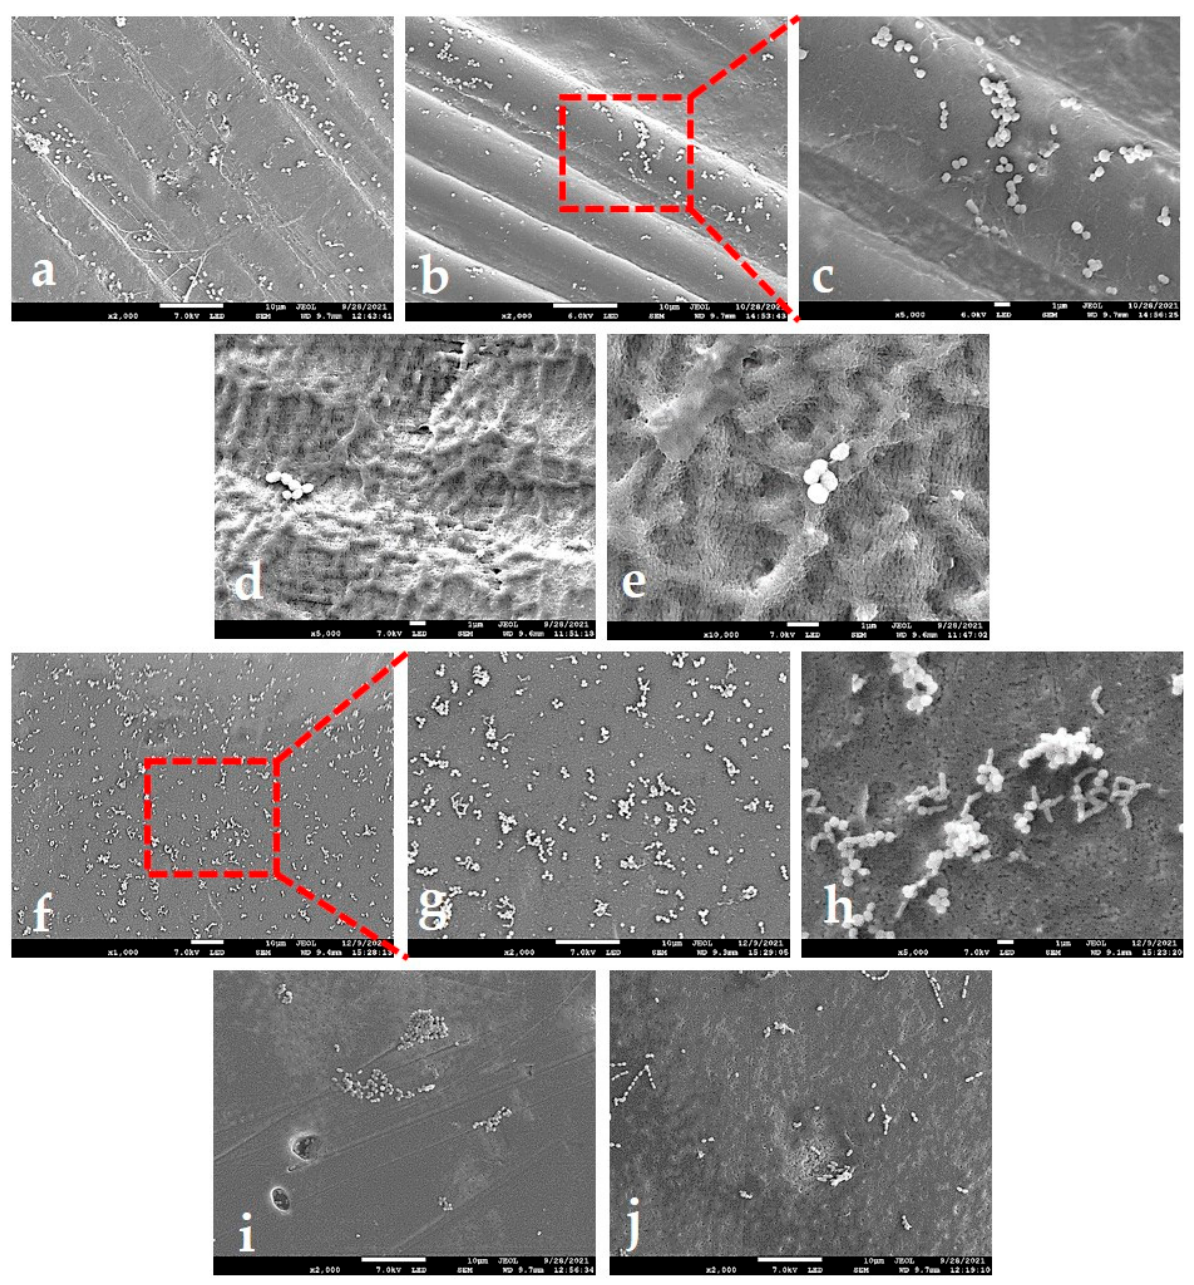
Figure 7. Representative SEM micrographs of bacteria adhering to PTFE membranes. ( a – c ) different magnifications of the corrugated area of PTFE-B (polytetrafluoroethylene-blue) membrane, containing thread-like structures; ( d , e ) bacteria adhering to PTFE-B in an area without thread-like structures; ( f – h ) different magnifications of “warts”-rich area of PTFE-W (polytetrafluoroethylene-white) membrane; ( i , j ) bacteria adhering on areas without “warts”.